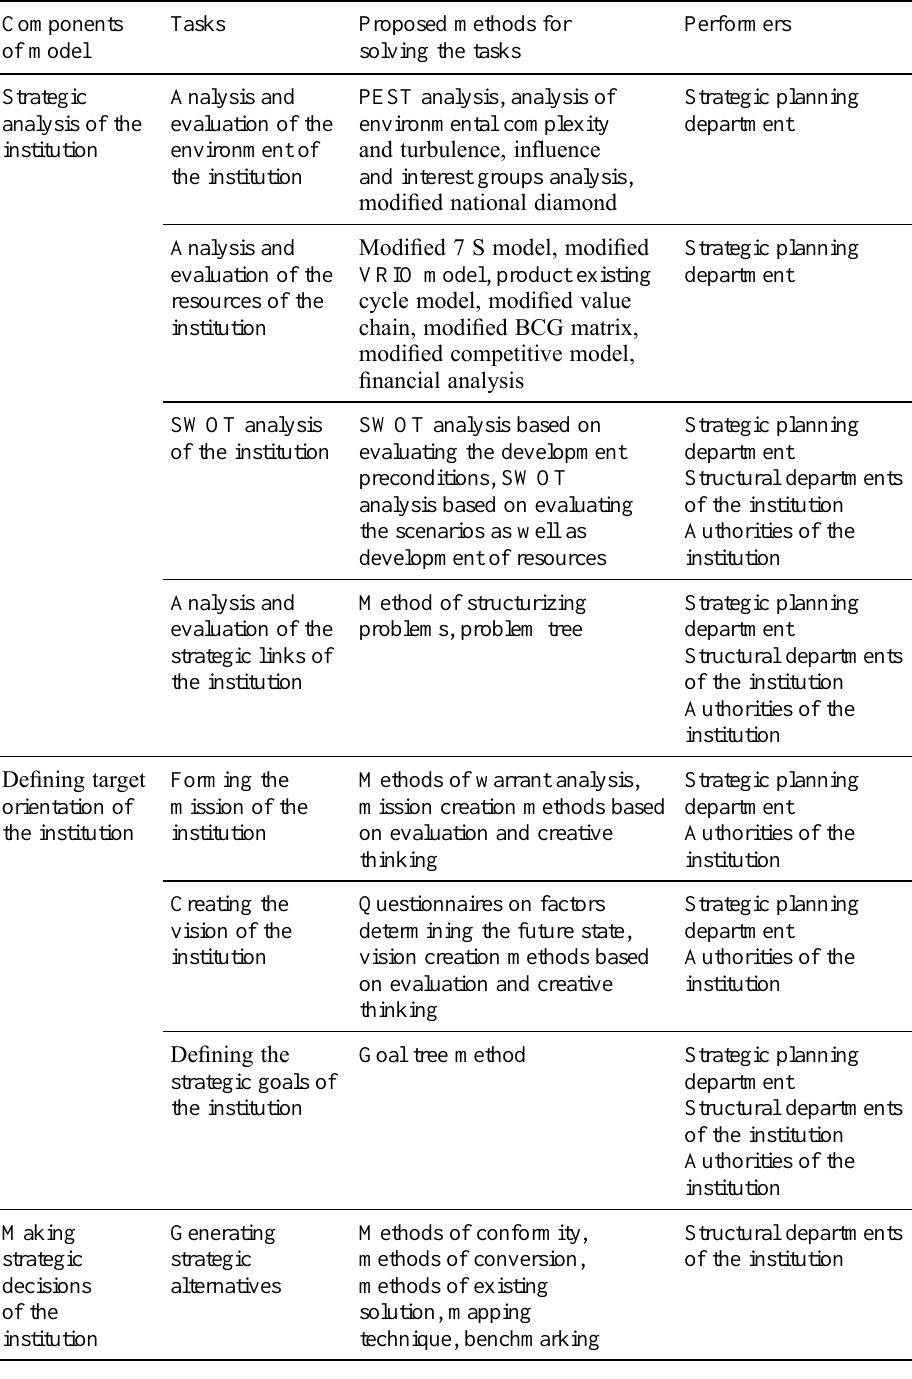
Table 2. The factors predetermining the requirements for integrated strategic planning